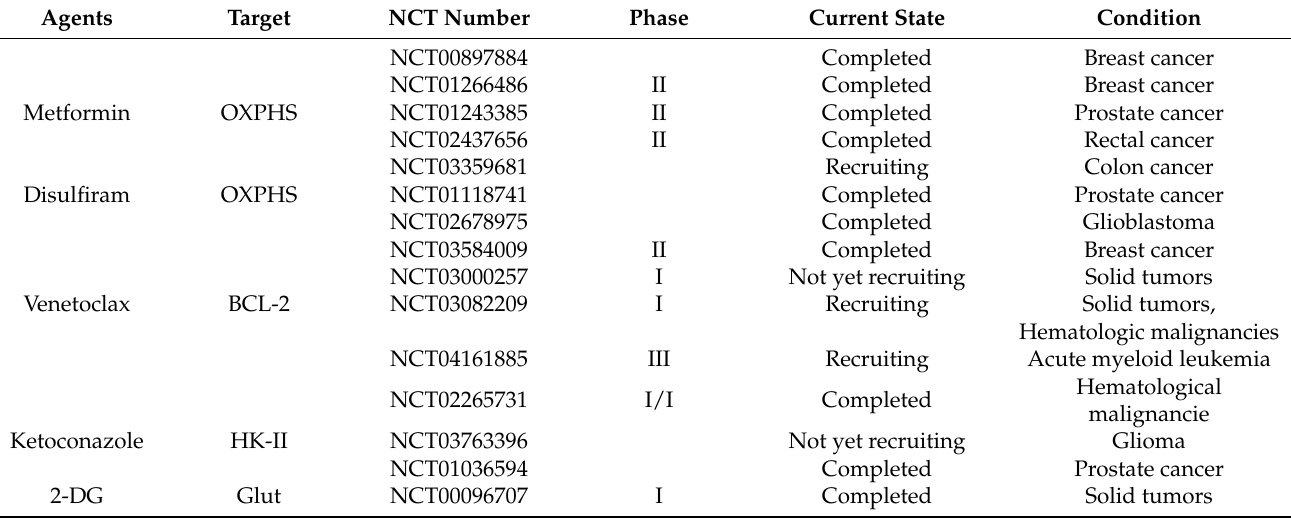
Table 4. Some agents targeting metabolic pathways of CSCs which have been evaluated in clinical